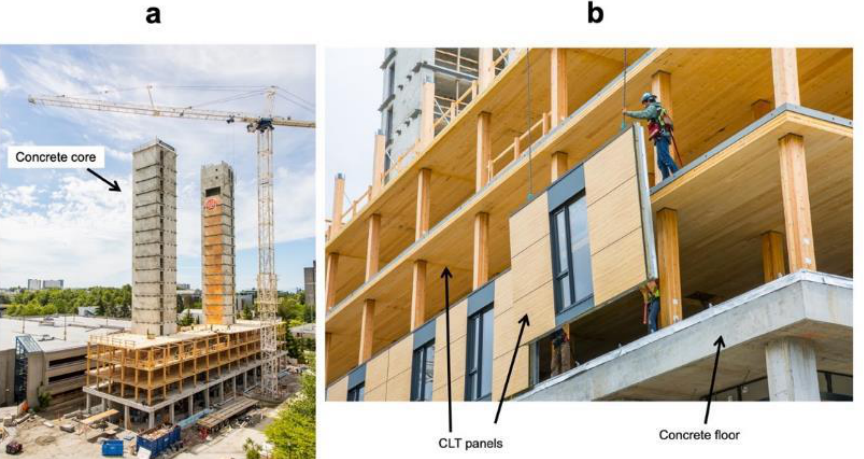
Figure 6. Brock Commons building progress: ( a ) concrete core and initial floor overview and ( b ) envelope cross laminated timber (CLT) panel installation. Modified from naturallywood.com; photographer: K.K. Law.